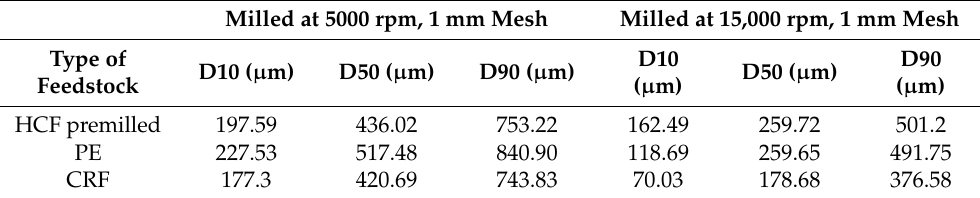
Figure 6. ( a ) PSD curve of feedstocks milled at 5000 rpm using a 1 mm mesh size. ( b ) PSD curve of feedstocks milled at 15,000 rpm using a 1 mm mesh size. Table 4. Particle size distribution of the ITZ ASD feedstocks milled at 5000 rpm and 15,000 rpm using a 1 mm mesh